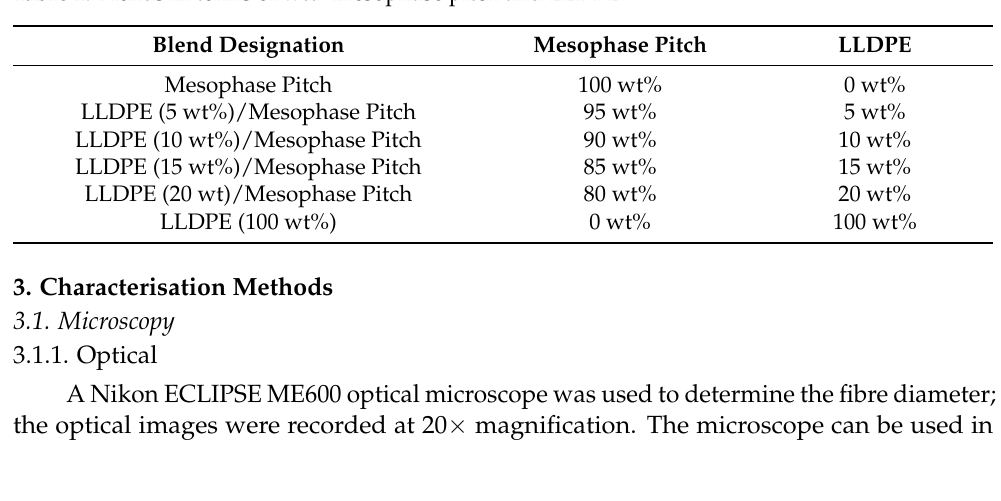
Figure 2. Schematic diagram of material processing. Table 1. Blends in terms of wt% mesophase pitch and